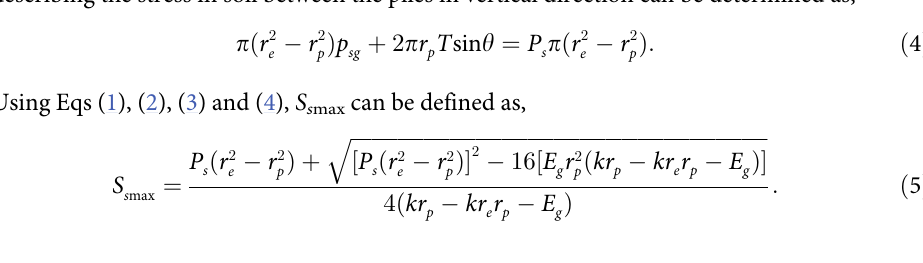
PLOS ONE | https://doi.org/10.1371/journal.pone.0256190 August 16,